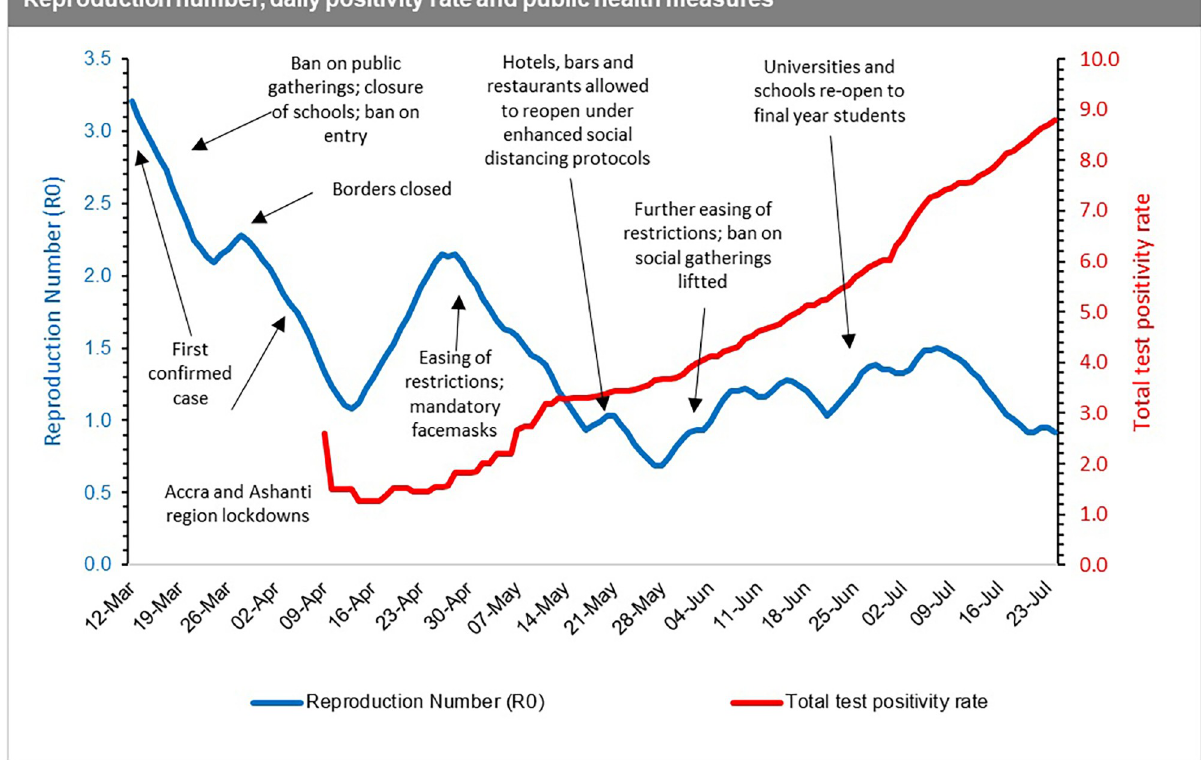
Fig 5. Time dependent R 0 superimposed on daily positivity rate in